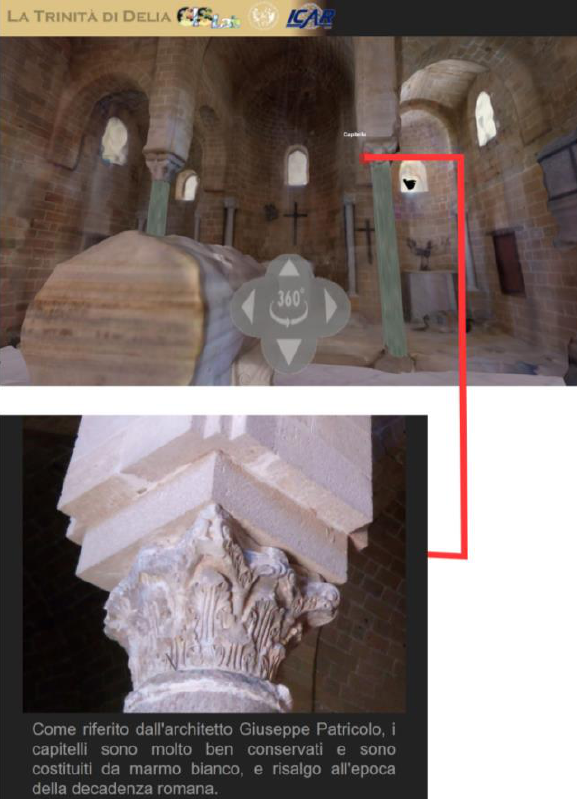
Figure 15. An internal view of the interactive navigation model accessible on web with the linked popup information